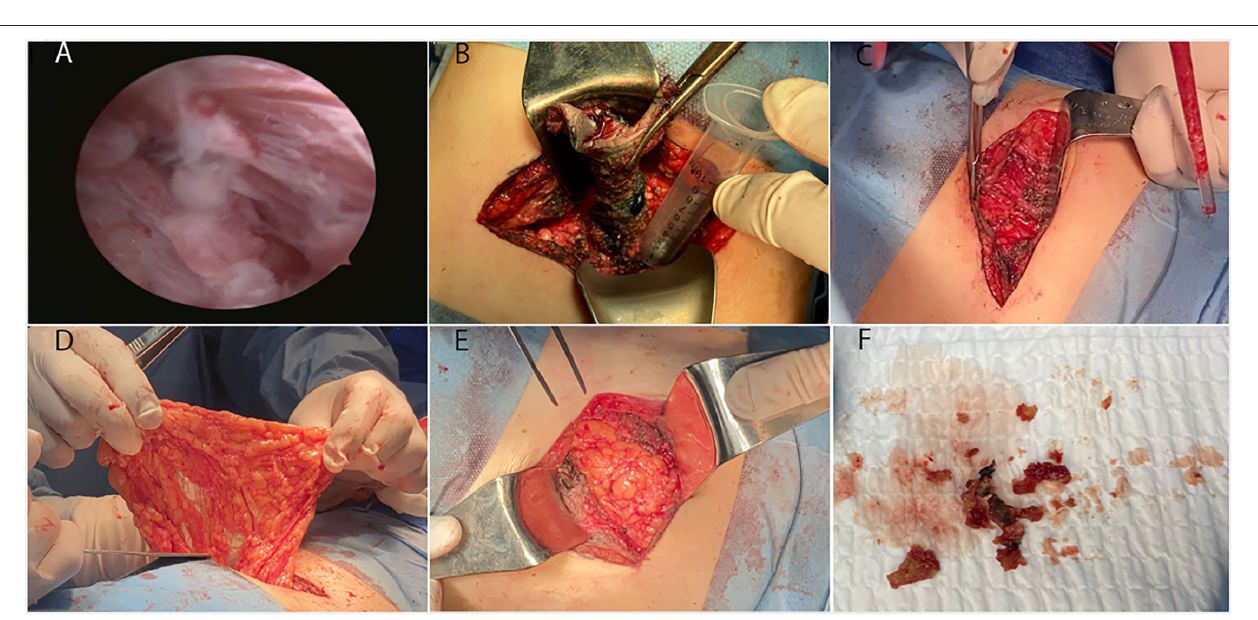
FIGURE 2 | The fistulous tract endoscopic images and manifestation of surgery . (A) The fistulous tract endoscopy showed a mass of white flocculus stuck to the lining of the sinus tract. Because of the twist of the tract, our hard endoscopy cannot reach the bottom of the sinus tract. (B) Complete excision of the sinus tract under the guidance of methylene blue staining. The length of the tract was 6 to 7cm. (C,F) A substantial amount of hard tissue similar to calcification and a hemoclip at the lower pole of the left kidney were founded. Removed all of these foreign objects. (D) Opened the posterior peritoneum and pulled part of the greater omentum tissue into the retroperitoneal space with oval forceps. (E) Tightly covered the left kidney with the omental flap. was still functioning, we decided to perform the NNS